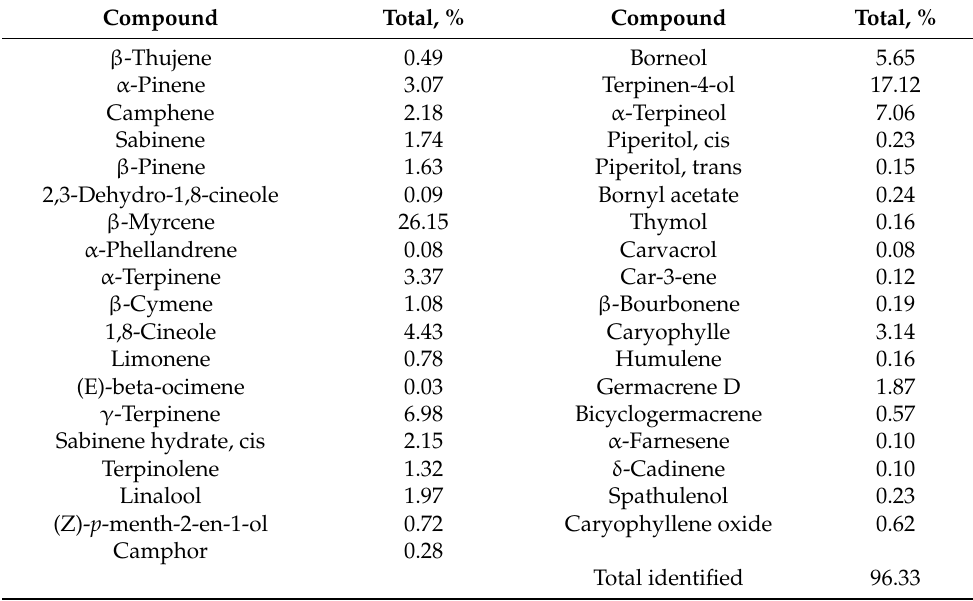
Table 2. Chemical components of the volatile oil in T. baicalensis